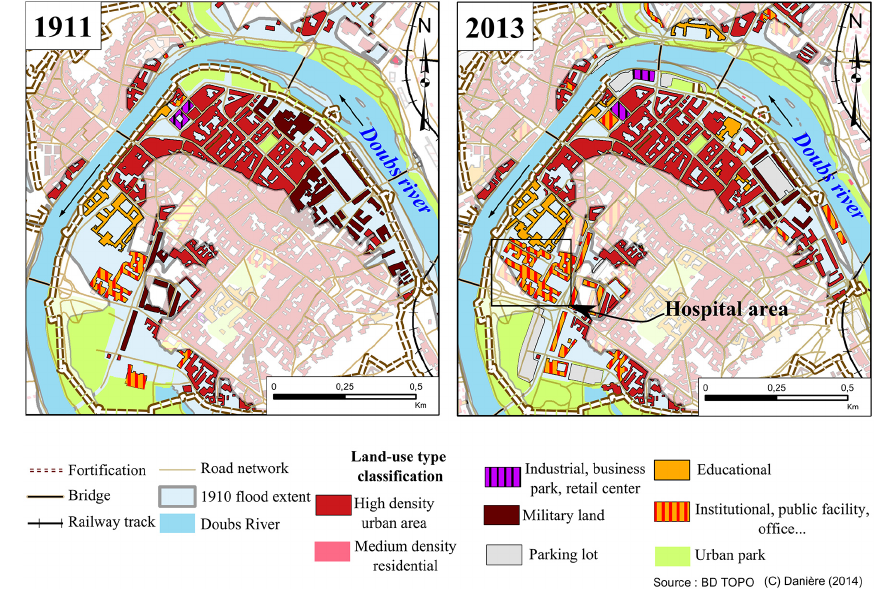
Figure 8. Land-use types and soil occupation within the area affected by the 1910 flood in Besançon: (a) in 1911 and (b) in 2013.